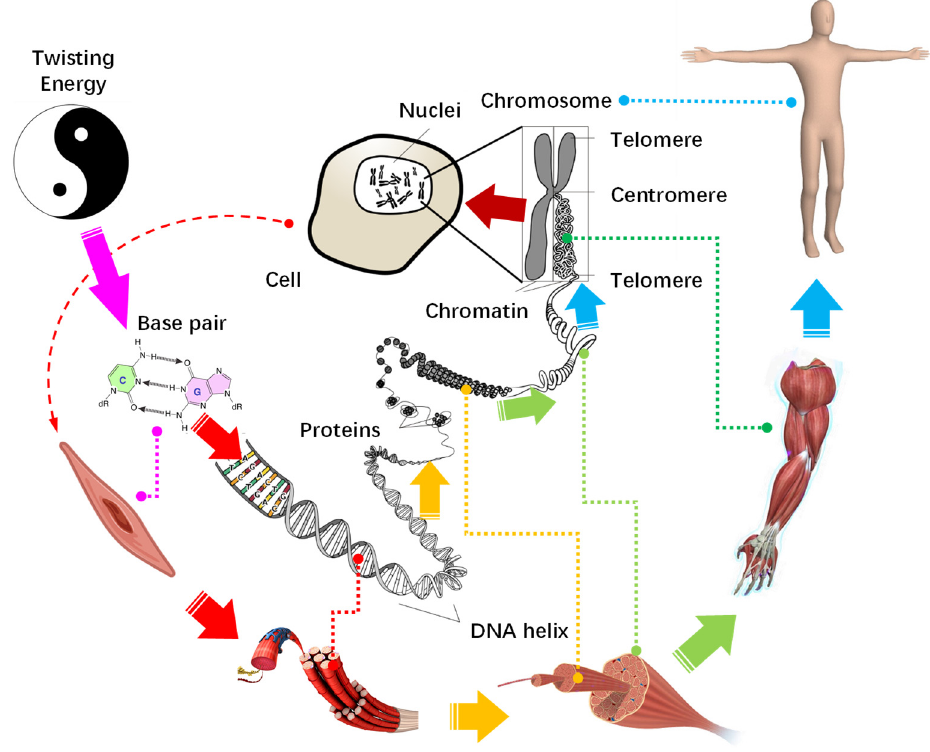
Figure 8. The construction route of life from a twisting energy level by level to an organism.